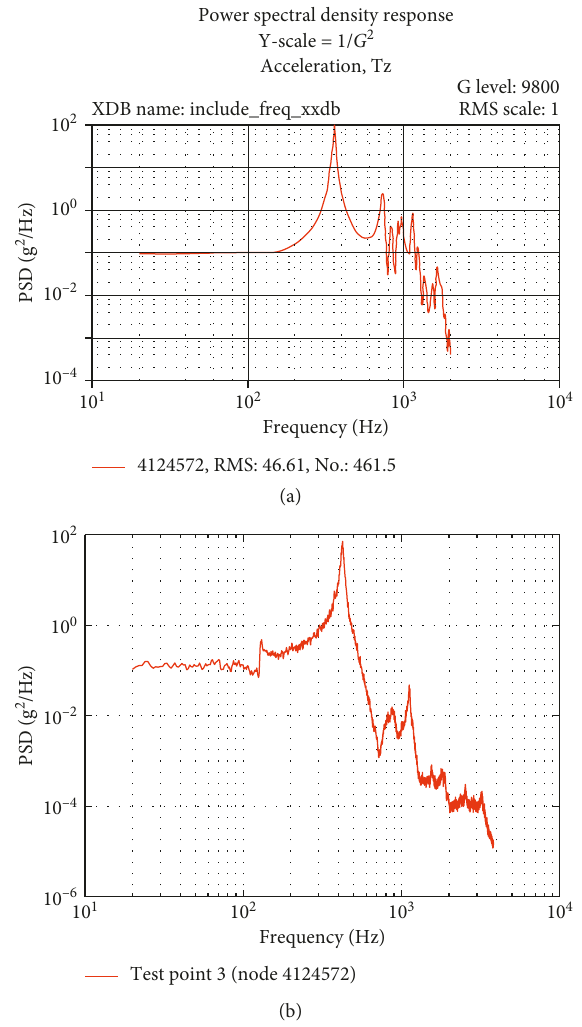
Figure 17: Random vibration response curves at reference point 3 in the Z direction. (a) Simulation curve. (b) Experimental